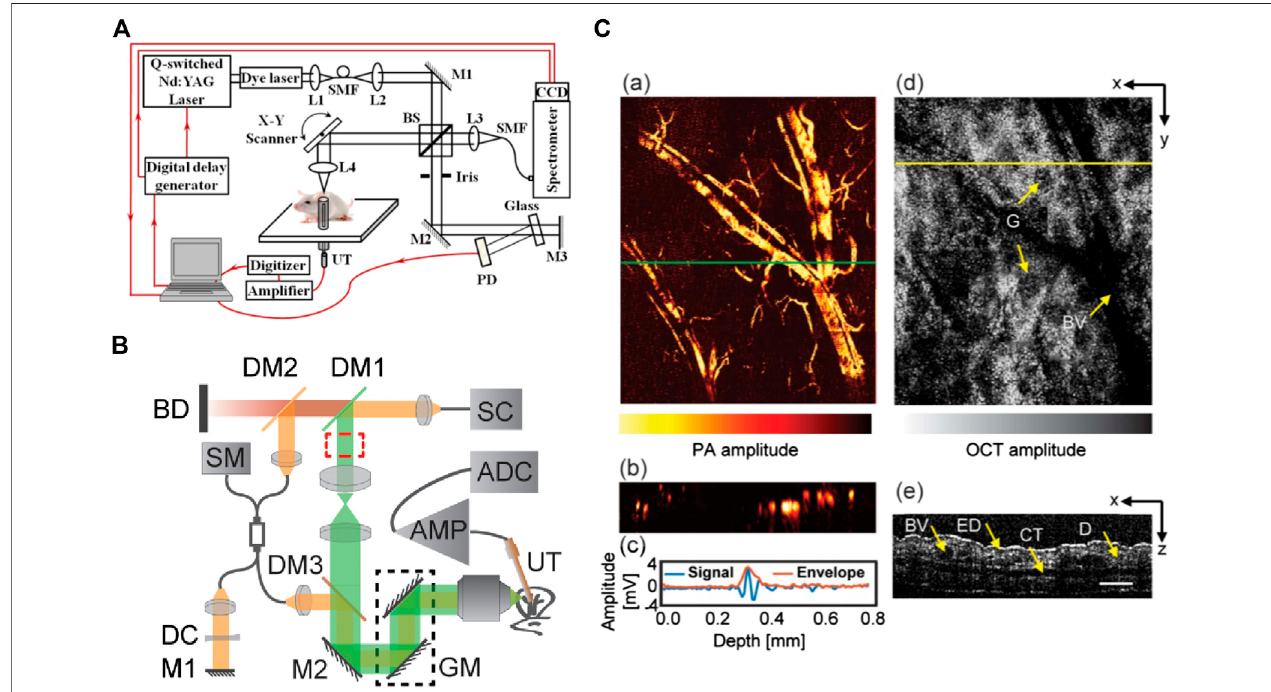
FIGURE 6 | (A) Schematic of the experimental system of a free-space OC-PAM. BS, beam splitter; SMF, single-mode fi ber; PD, photodiode; UT, ultrasonic transducer; L, lens, M, mirror. Reprinted with permission from [14]. (B) Schematic of PAM-OCT system setup. SC, supercontinuum; DM, dichroic mirrors; GM, galvanometer;UT, ultrasoundtransducer;AMP,ampli fi er;ADC,digitizer; SM,spectrometer;DC,dispersioncompensatingslab;M,mirrors;BD,beam dump.Reprinted withpermissionfrom[129]. (C) Results of invivo mouse earimaging. (a) En-facePAMimage; (b) PAMB-scan taken fromlocation indicatedbythegreenlinein (a) . (c) Typical PA A-line and its signal envelope obtained by a Hilbert transform. (d) En-face OCT image. G, gland; BV, blood vessel. (e) OCT B-scan taken from location indicated by yellow line in (d) . ED, epidermis; CT, cartilage; D, dermis. Scale bar, 150 μ m. Reprinted with permission from